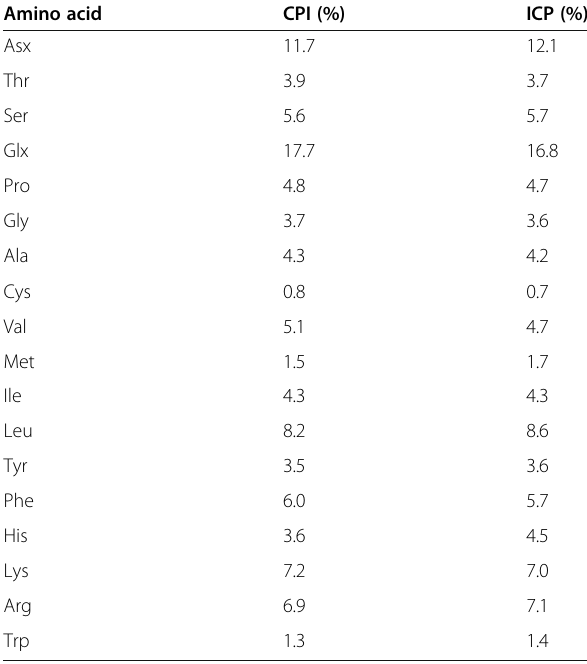
Table 1 Amino acid composition of cowpea protein isolate (CPI) and indigestible cowpea protein (ICP) a Amino acid CPI